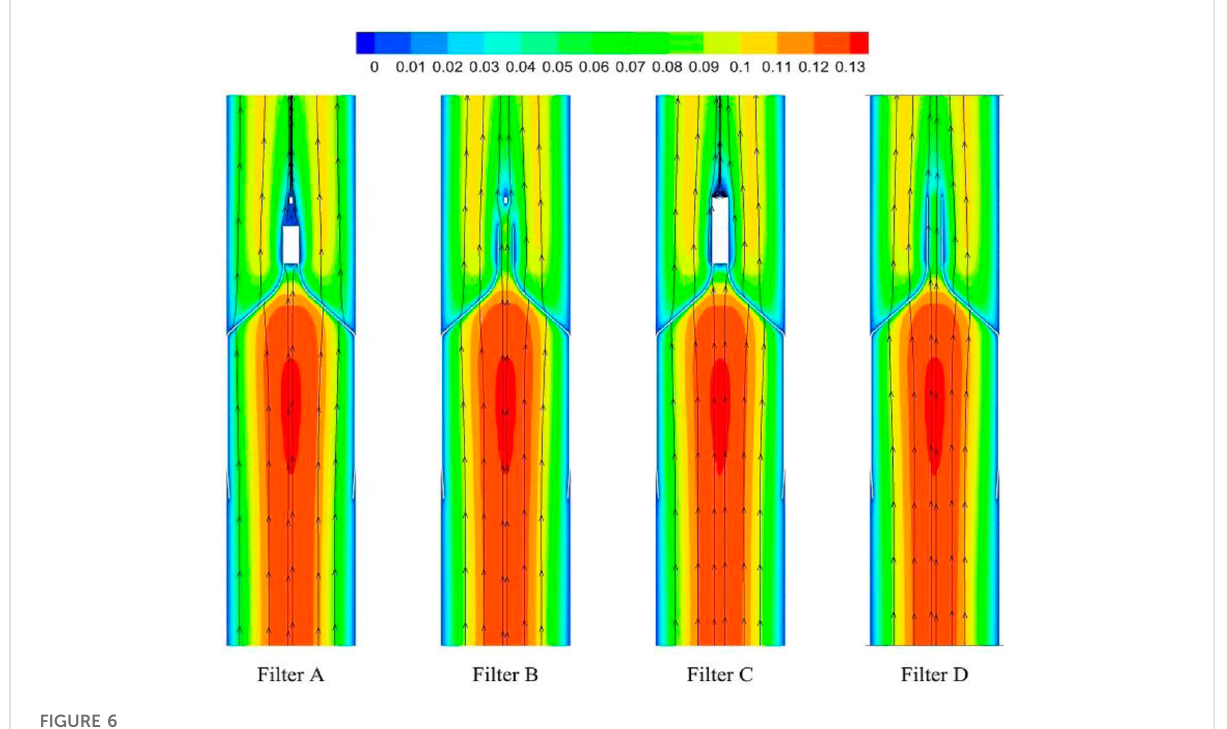
FIGURE 6 Blood fl ow velocity distribution in axial section.